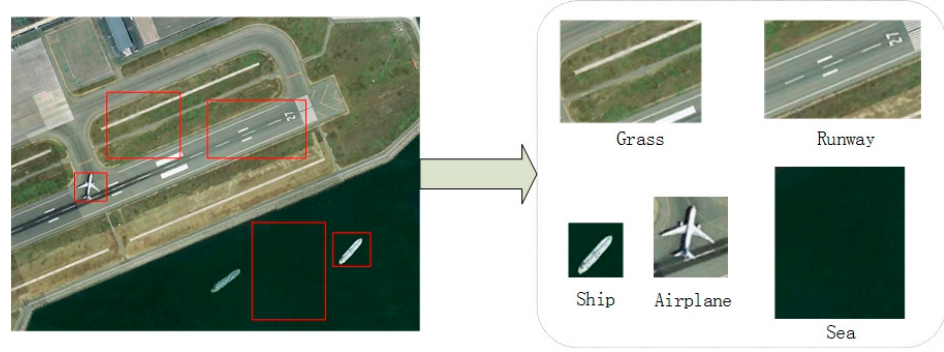
Figure 1. The contextual information in a remote sensing image.